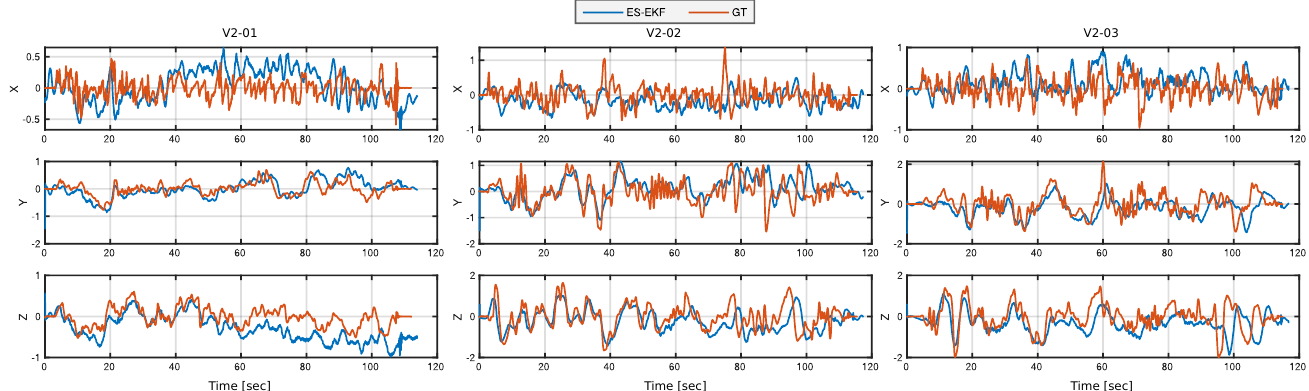
Figure 7. Estimated velocity profile validation with the ground truth. Comparison of sample sequences from EuRoC